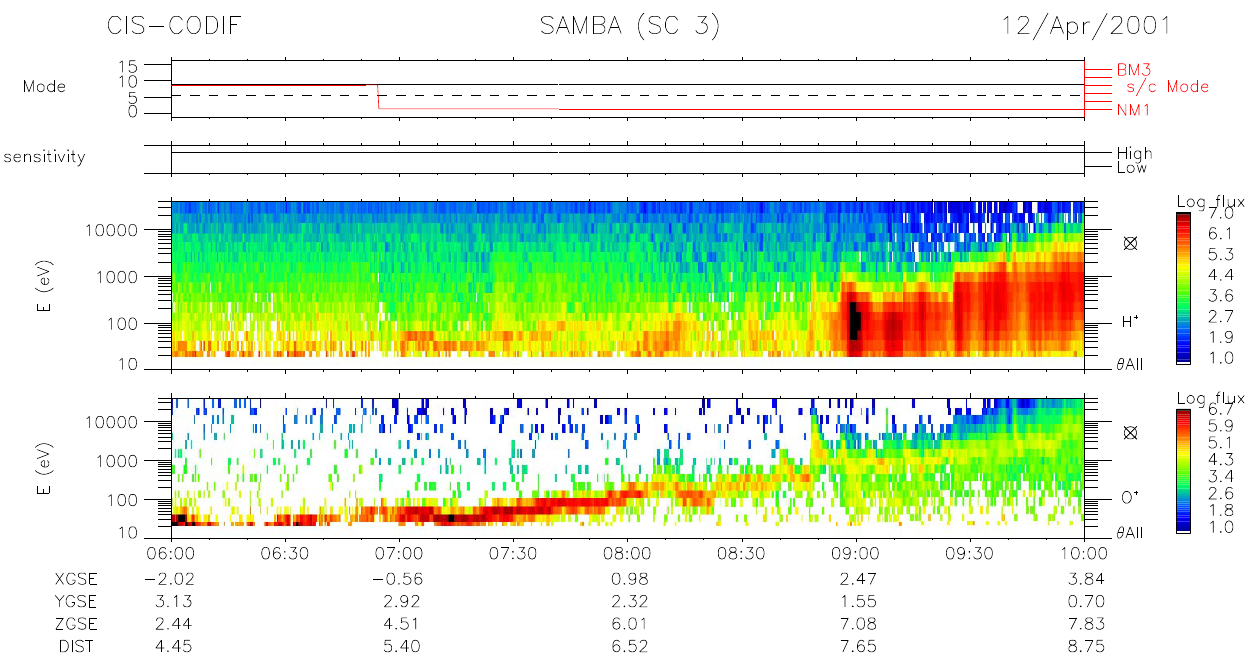
Fig. 3. Cluster spacecraft 3 (Samba) data from 12 April 2001. Panel 1 shows spacecraft mode, panel 2 instrument mode. Panels 3 and 4 show the H + and O + energy spectrograms, particle flux integrated over all